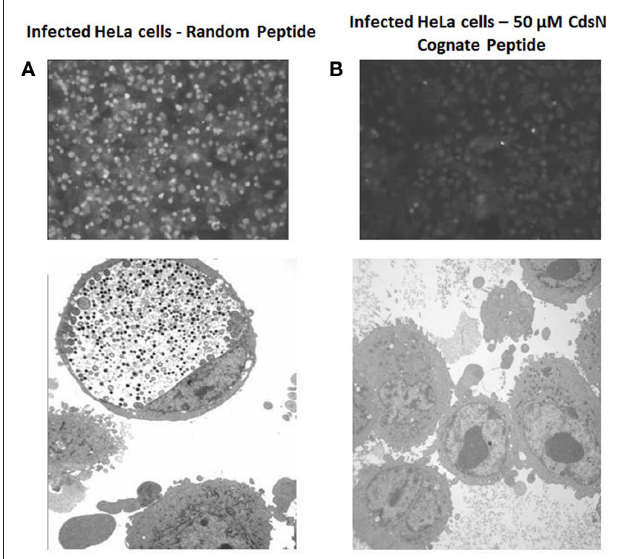
FIgure 7 | CdsN peptide reduces chlamydial infectivity of HeLa cells by IF staining and eM. HeLa cells were pretreated with CdsN or a control peptide (MTS–MFAVNAQ), then infected with Chlamydia pneumoniae at an MOI of 3 and examined by either IF staining using anti-MOMP monoclonal antibody treatment with the pathfinder kit (top) or by electron microscopy (bottom). (A) HeLa cells treated with the control peptide (100 μM) and infected with C. pneumoniae. Immunofluorescent staining reveals numerous infected cells (top) while electron microscopy reveals a large inclusion body with both EBs and RBs (bottom). (B) HeLa cells treated with the CdsN peptide (50 μM) and infected with C. pneumoniae. Evaluation of over 200 cells treated with the CdsN peptide by IF staining and EM examination revealed a drastic reduction in C. pneumoniae infected cells and a complete lack of detectable inclusions by